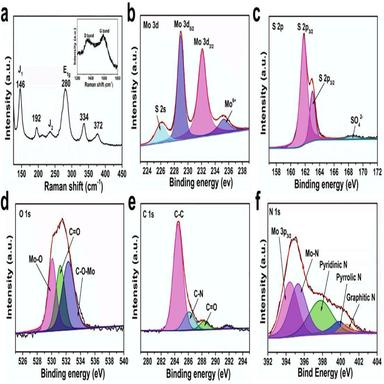
(a) Raman spectra, high resolution XPS spectra of (b) Mo3d, (c) S2p, (d) O1s, (e) C1s and (f) N1s of 1 T-MoS2/MoOx@NC.